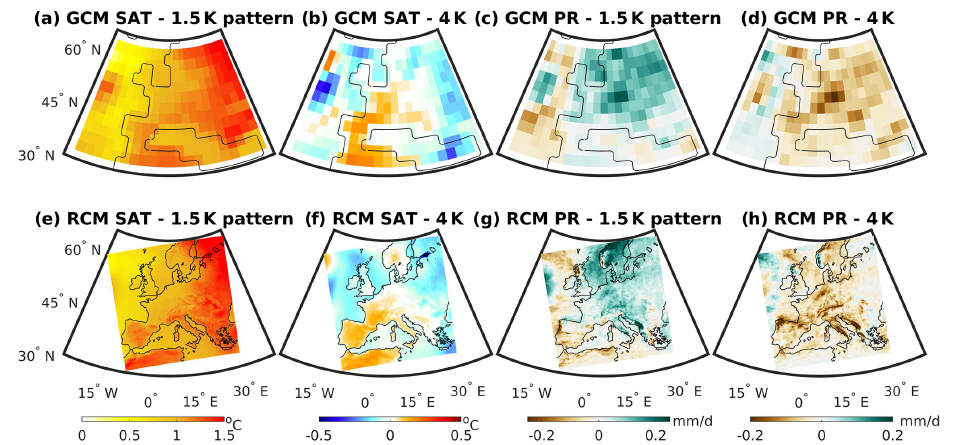
Figure 2. Surface air temperature (SAT) and precipitation change over Europe scaled by the globally averaged SAT change. (a) Scaled SAT change at 1.5K in the GCM, (b) scaled SAT change at 4K with scaled SAT change at 1.5K subtracted in the GCM, (c) scaled precipitation change at 1.5K in the GCM, (d) scaled precipitation change at 4K with scaled SAT change at 1.5K precipitation in the GCM, (e) Scaled SAT change at 1.5K in the RCM, (f) scaled SAT change at 4K with scaled SAT change at 1.5K subtracted in the RCM, (g) scaled precipitation change at 1.5K in the RCM, and (h) scaled precipitation change at 4K with scaled SAT change at 1.5K precipitation in the RCM. Changes are computed relative to the pattern at 1K of global warming. Continental borders are shown for the each model’s native grid. The scaled changes in panels ( a ) and ( d ) are computed as the pointwise SAT at 1.5K minus the pointwise SAT at 1K dived by the global mean warming above 1K (i.e. 0.5K) in each individual ensemble member. The patterns in (b) and (f) use the same calculation at 4K, with the patterns from (a) and (e) subtracted from them. The ensemble mean is taken prior to the subtraction. The same process is computed in the right-hand panels for